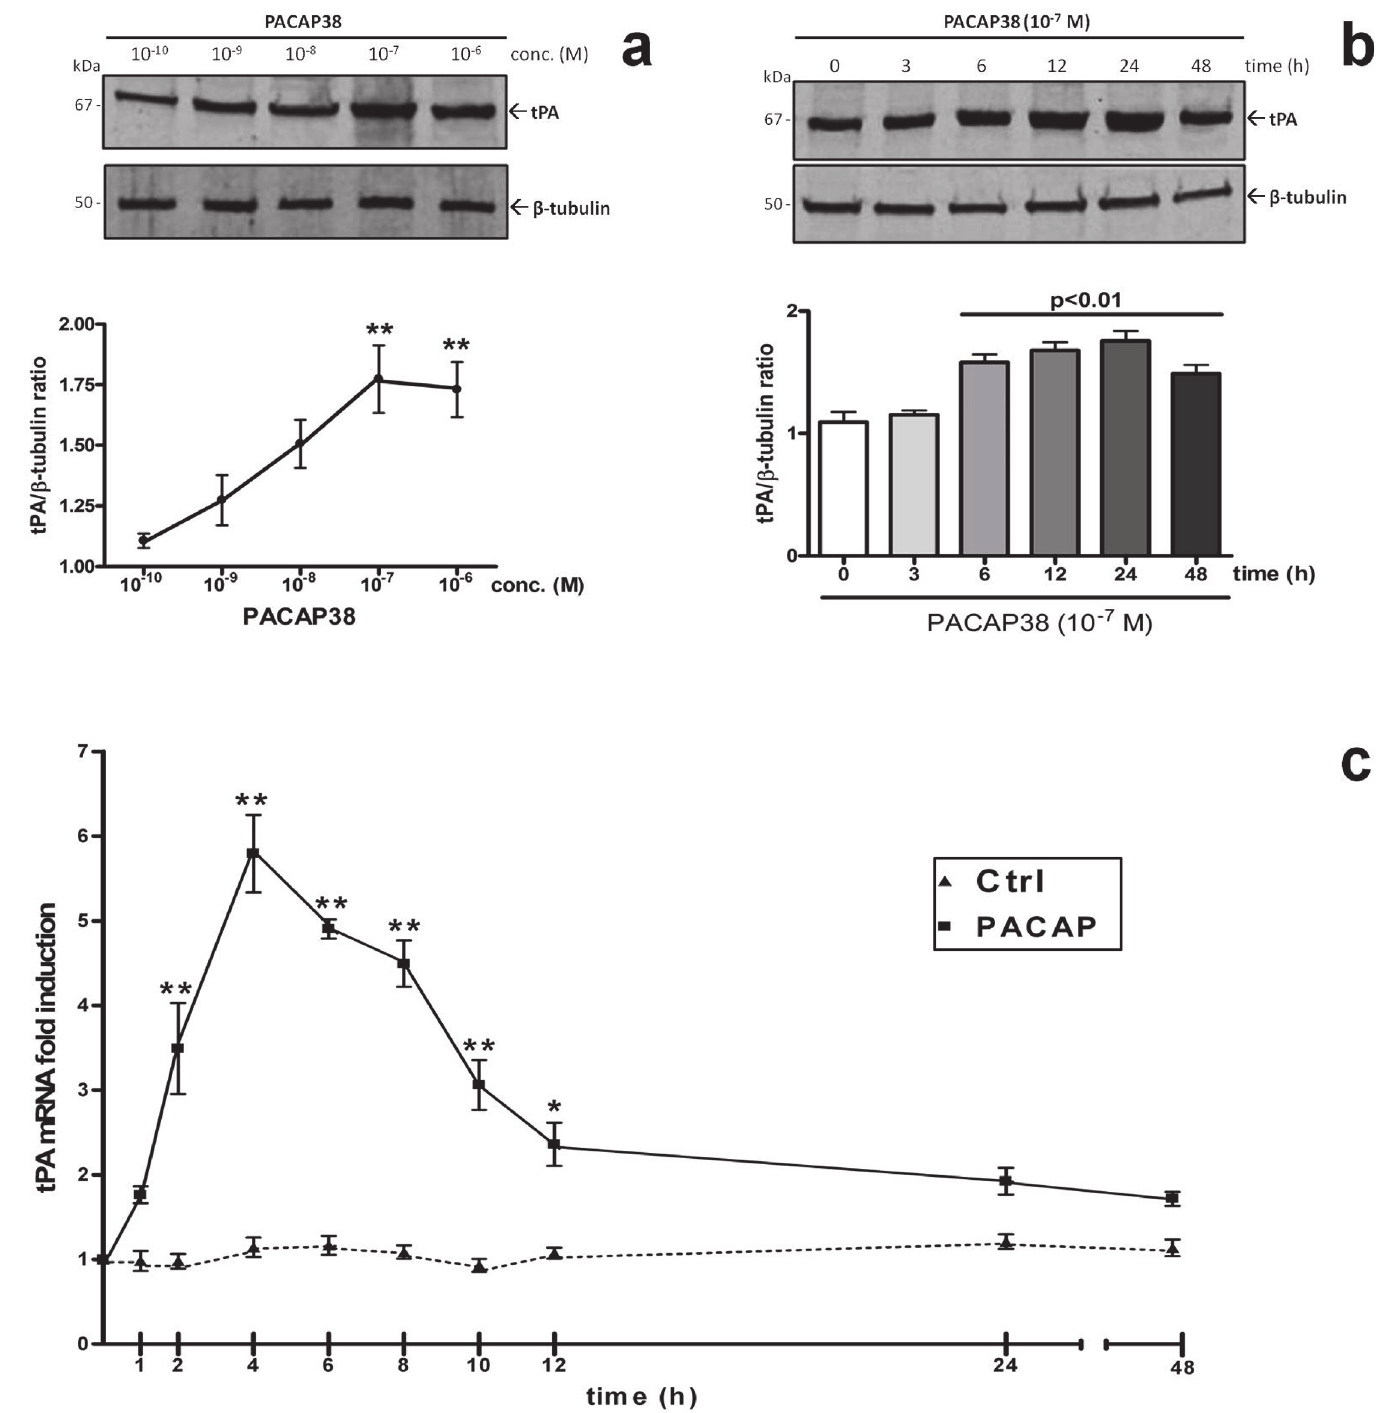
Fig. 1. Dose- and time-dependent effects of PACAP on tissue plasminogen activator (tPA) mRNA and protein expression. Representative immunoblots and densitometric analyses ( a – b ) showing the effects of increasing concentrations of PACAP38 (10 − 10 M to 10 − 6 M, respectively) or ( a ) of a single concentration of the peptide (10 − 7 M) on tPA protein expression at different time points (0, 3, 6, 12, 24, 48h). Protein extracts (20 μ g) obtained from rat RT4-D6P2T cultures grown as described were separated by SDS-PAGE and transferred to nitrocellulose membranes. Then, membranes were incubated using a rabbit anti-tPA (1:300, sc-15346, Santa Cruz Biotechnology) and a rabbit anti- β -tubulin antibody (H-235, cat n. sc-9104, Santa Cruz Biotechnology; 1:500) and scanned with an Odyssey Infrared Imaging System, as described in Materials and Methods section. Densitometric analyses were performed using the ImageJ software and values obtained were normalized to β -tubulin, which was used as loading control. Results are expressed as the average